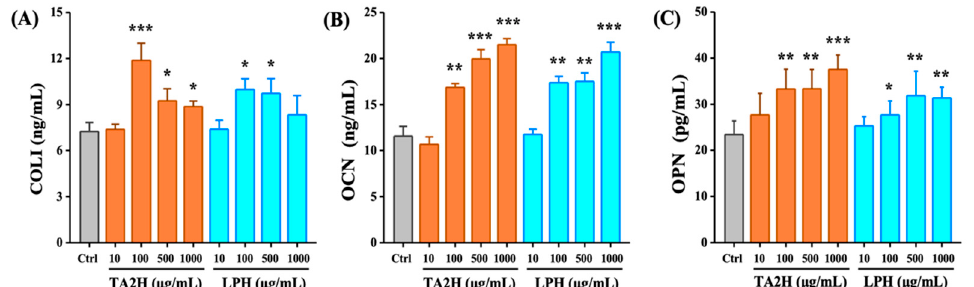
Figure A1. Effects of whey protein hydrolysates (TA2H and LPH) on osteoblastic differentiation markers in preosteoblast cells. MC3T3-E1 cells were seeded on six-well plates and were treated with 0 (control group), 10, 100, 500, and 1000 µ g/mL of TA2H and LPH for 3 days to detect ( A ) COLI content in culture medium or cultured for 6 days to detect ( B ) OCN and ( C ) OPN content in culture medium. Data are the mean ± SEM from 4–6 independent experiments. *, **, and *** indicate p < 0.05, p < 0.01, and p < 0.001, as compared to the control group.